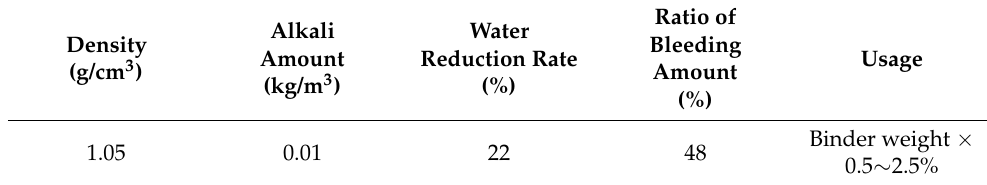
Table 1. Physical properties of AEWR.